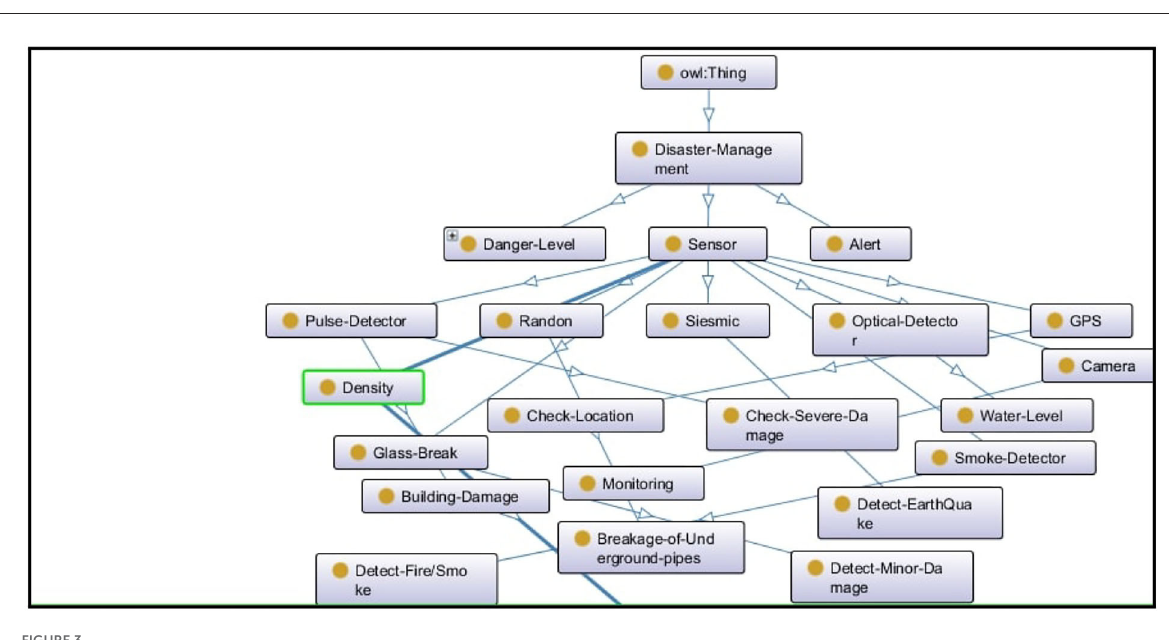
FIGURE3 Onto-graph to show the system